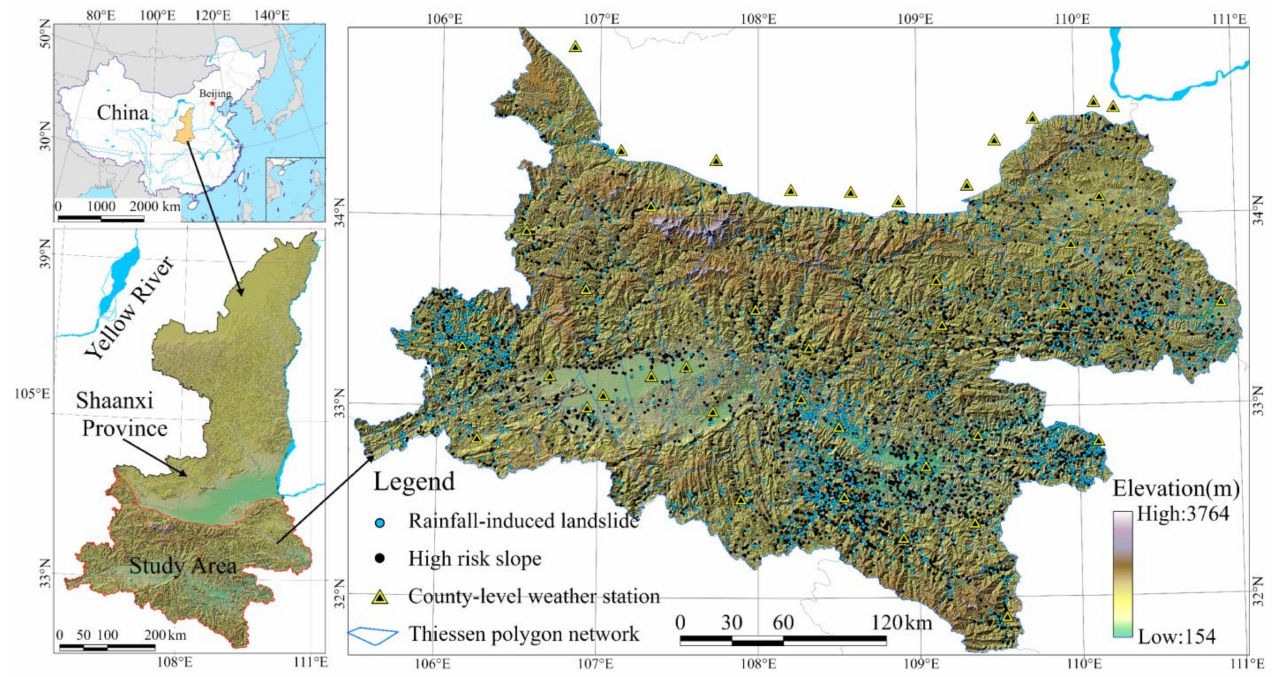
Figure 2. Geographic location and rainfall-induced shallow landslide